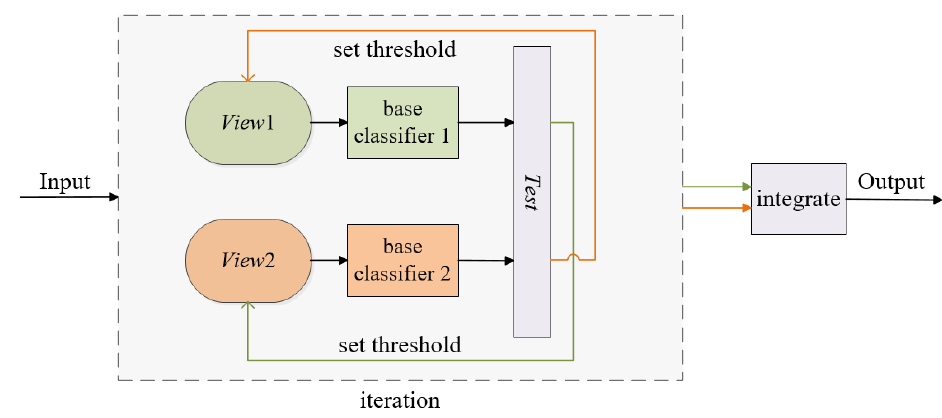
Figure 1. The process of co-training.